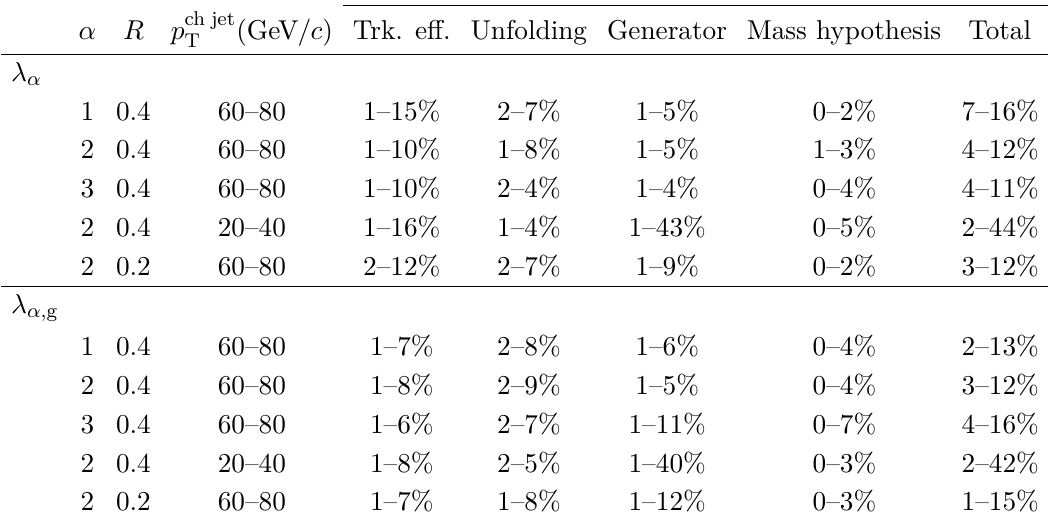
Table 2 . Summary of systematic uncertainties for a representative sample of α , R , and p ch jet moderately high 60 < p ch jet < 80 GeV /c with R = 0 . 4 is chosen to show the variation with α , and T two additional rows show the trends with smaller p ch jet